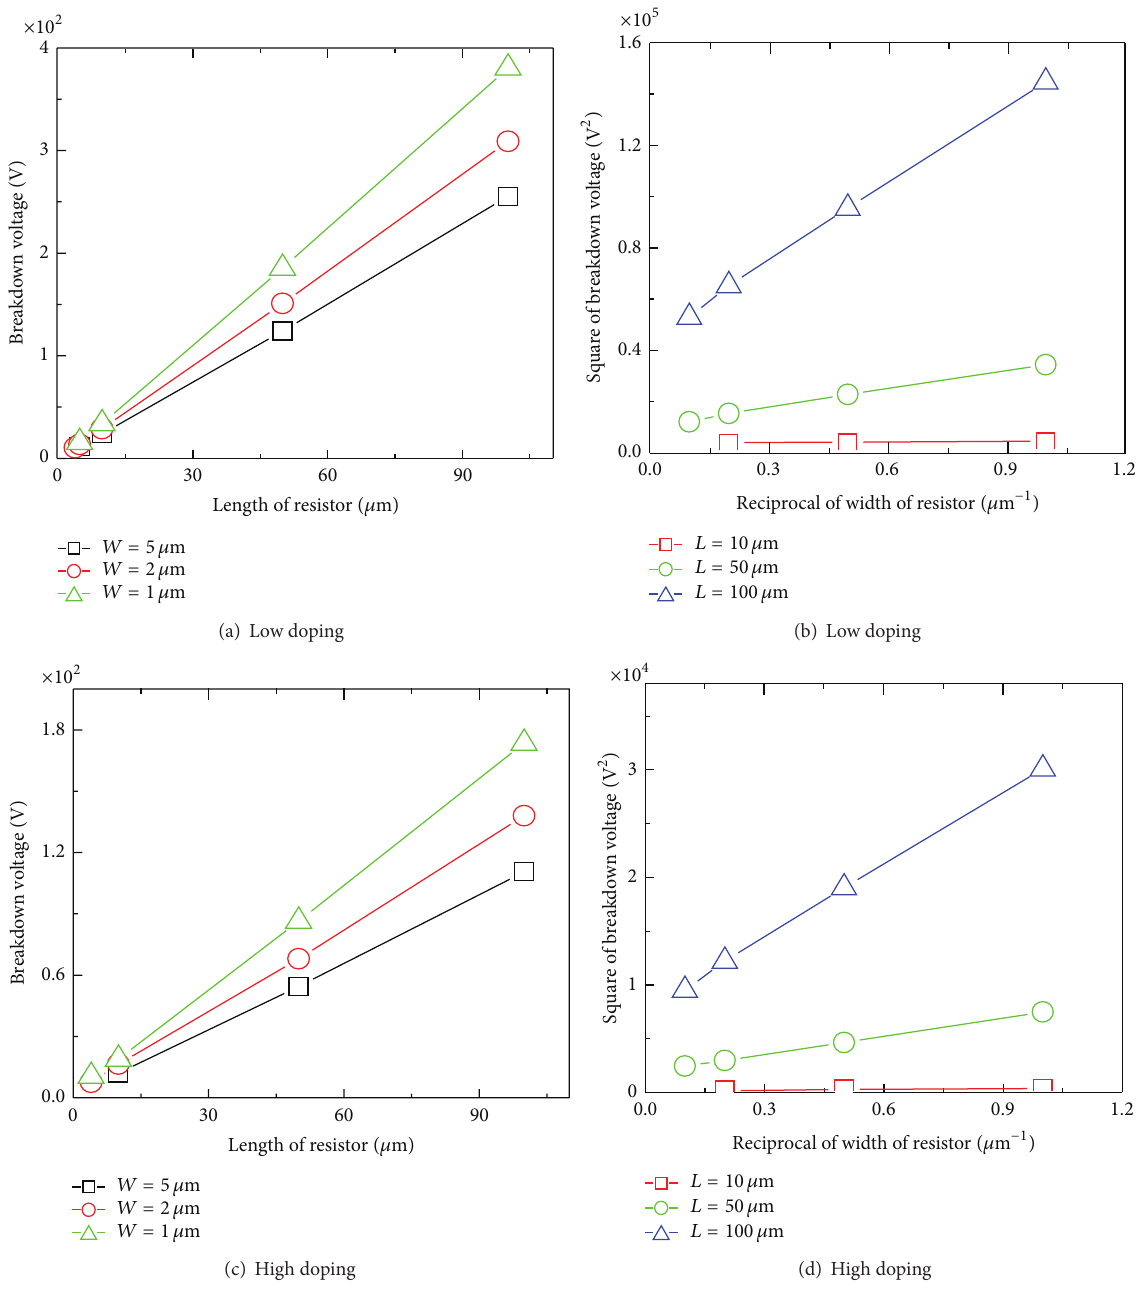
Figure 4: 𝑉 versus length of the resistor ((a) and (c)) and square of 𝑉 BD (a) and (b) come from lightly doped resistors while (c) and (d) come from highly doped ones.